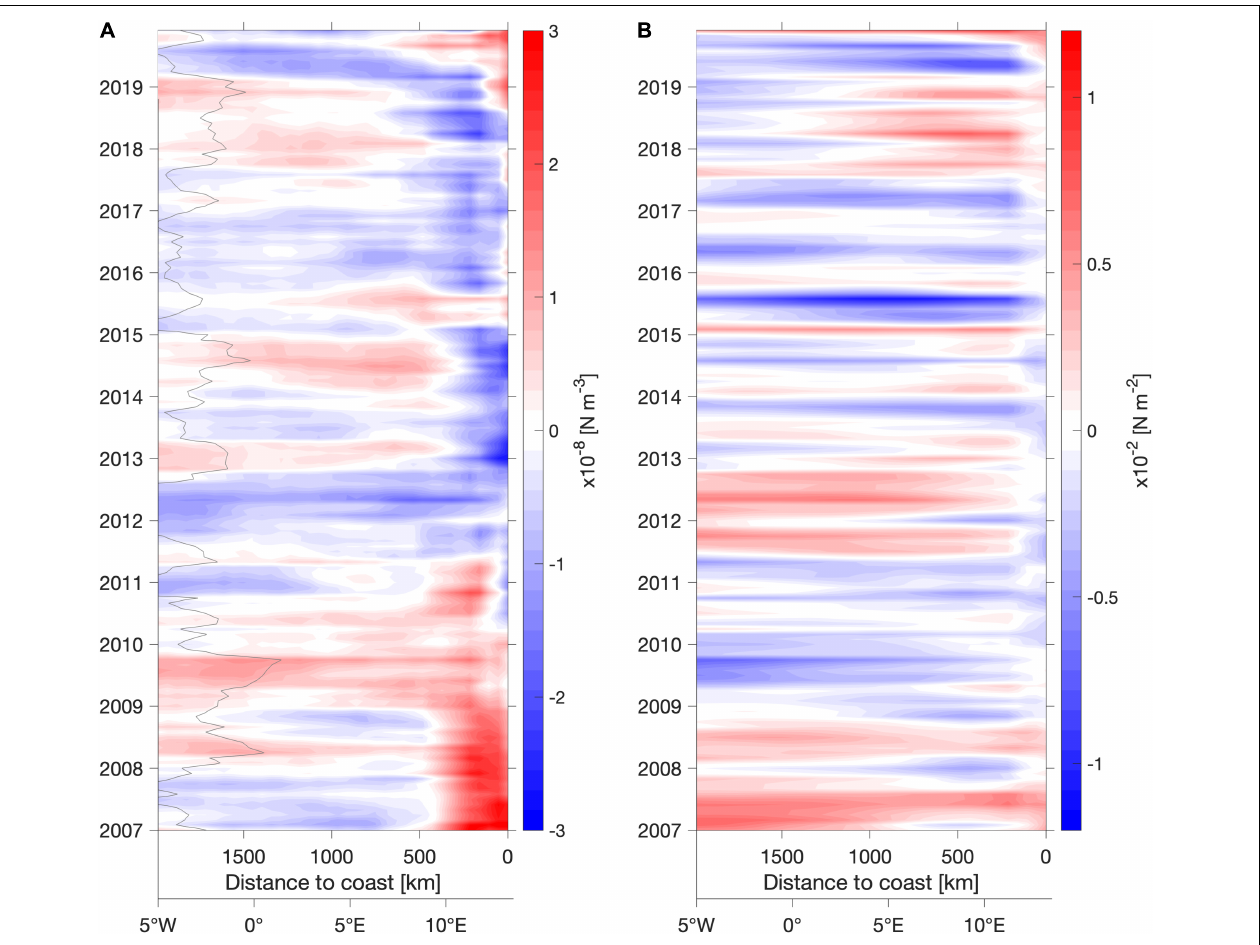
FIGURE 11 | Six months running mean of (A) wind stress curl anomaly and (B) meridional wind stress anomaly meridionally averaged in SETA (10–20 ◦ S, 5 ◦ W–15 ◦ E) as a function of distance to the coast (at about 13.5 ◦ E) and time as inferred from Copernicus Marine environment monitoring service. Anomalies are computed relative to the monthly mean of the period of 2007–2019. Gray contour line in (A) indicates the zero-line of the mean wind stress curl, i.e., east of this line the mean wind stress curl is negative while west of this line it is